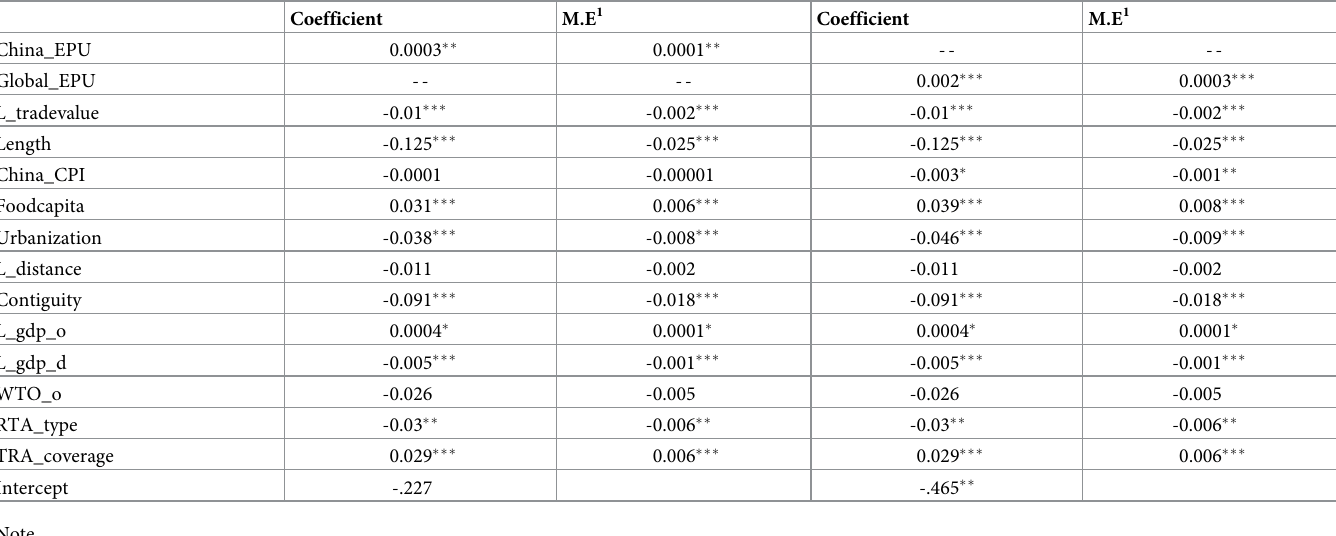
Table 5. Empirical results of discrete survival model (Eq